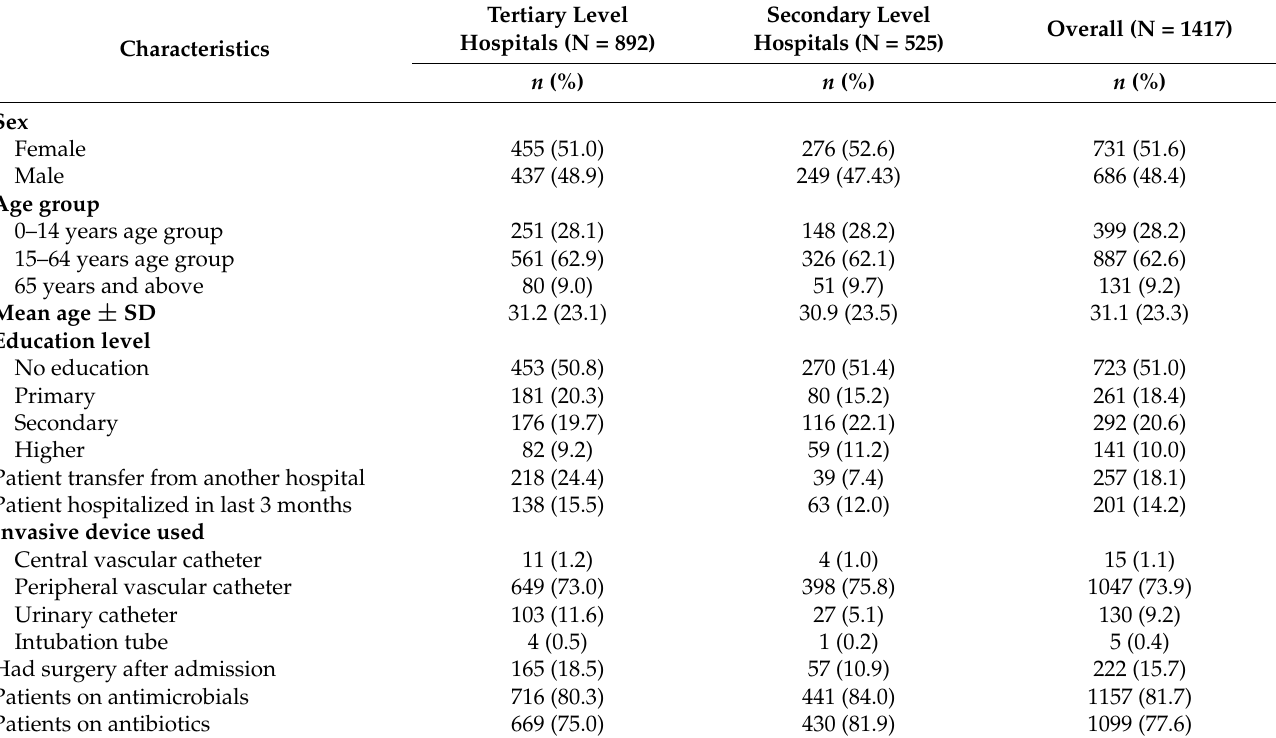
Table 1. Demographic and clinical characteristics of the patients enrolled in the point prevalence survey of antimicrobial usage at tertiary and secondary level hospitals in Bangladesh from February to April